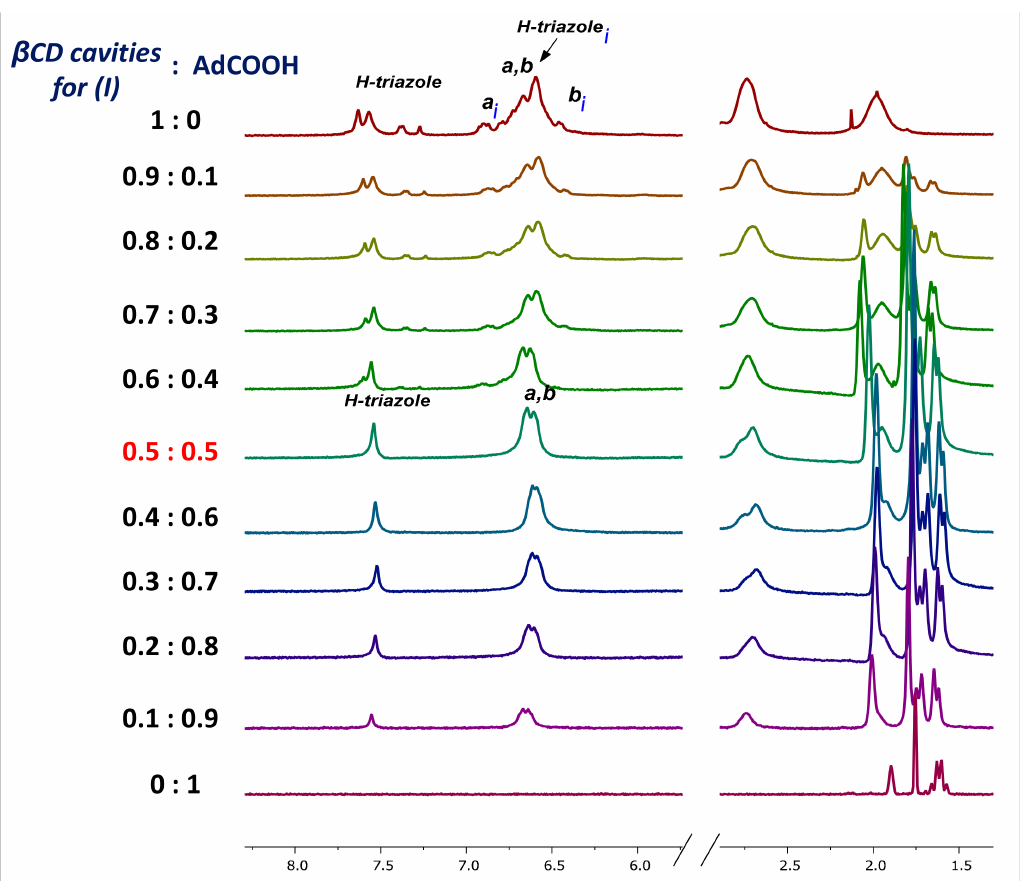
Figure 8. 1 H-NMR titration experiment of dendritic compound ( I ). The 5.5–8.5 ppm and 1.0–3.0 ppm regions are shown for the mixtures of dendritic compound ( I ) and AdCOOH in D 2 O with decreasing molar fraction from top to bottom, expressed with respect to the concentration in β CD cavities for dendritic compound ( I ) (XCD = [ β CD]/([ β CD] + [AdCOOH]). Total concentration [ β CD] + [AdCOOH] = 3